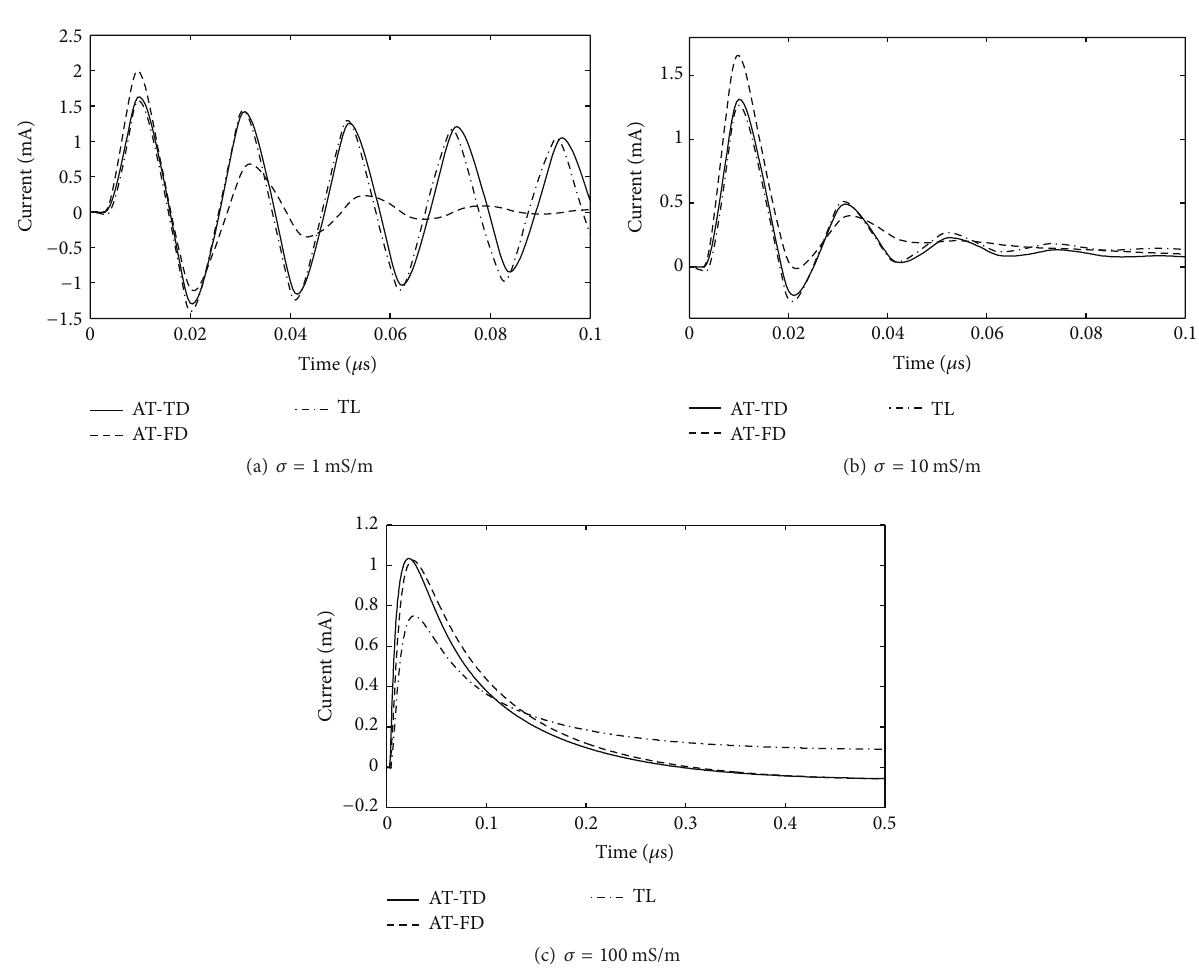
Figure 2: Transient current at the centre of the straight wire: 𝐿 = 1 m and 𝑑 = 30